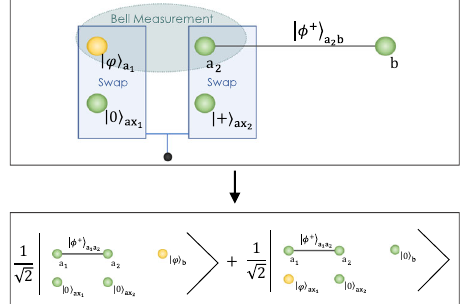
Fig. 3 Controlled sending. Schematic representation of controlled sending, both the initial state (top) and the fi nal superposition (bottom). Party A possesses four qubits that are coherently either swapped or not in a controlled and simultaneous way, followed by a Bell measurement of the auxiliary systems ax 1 , ax 2 . A superposition of the state φ j i teleported and kept by A (i.e., not sent) is